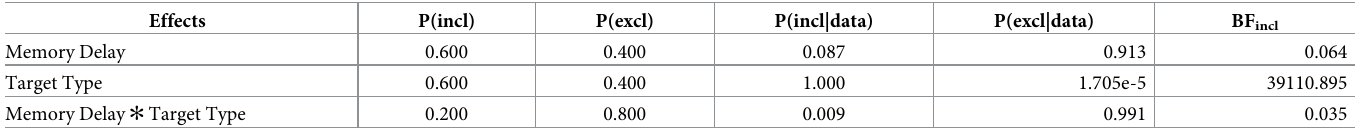
Table 4. Follow-up ANOVA for other, non-illusory